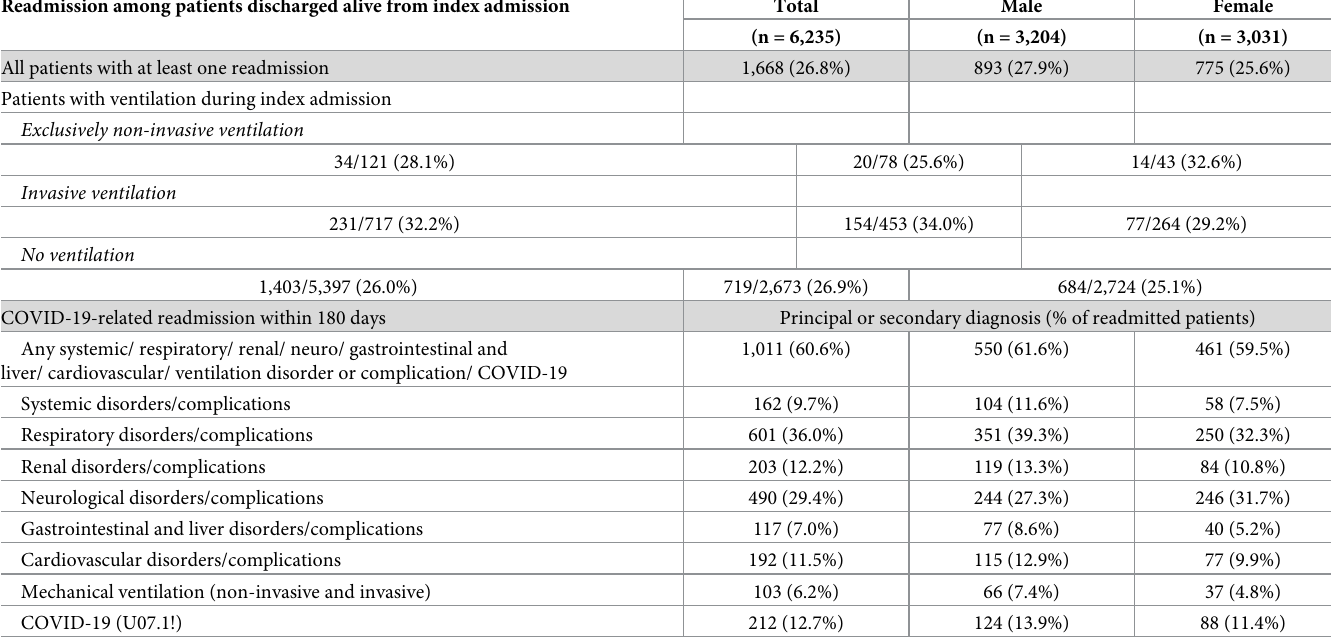
Table 2. Readmission within 180-days of